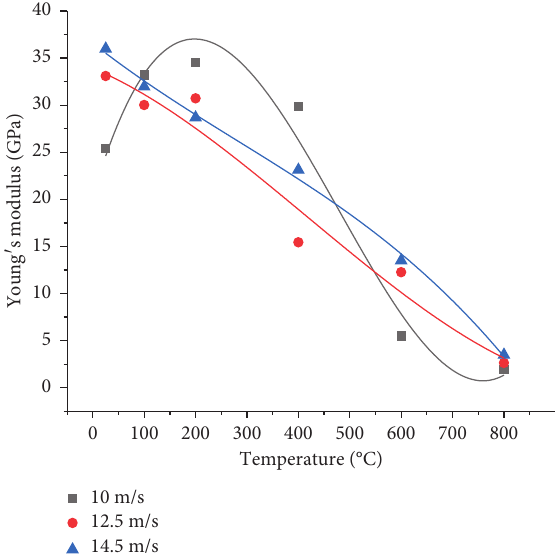
Figure 18: Young’s modulus-temperature curves of rock under different impact speeds and different